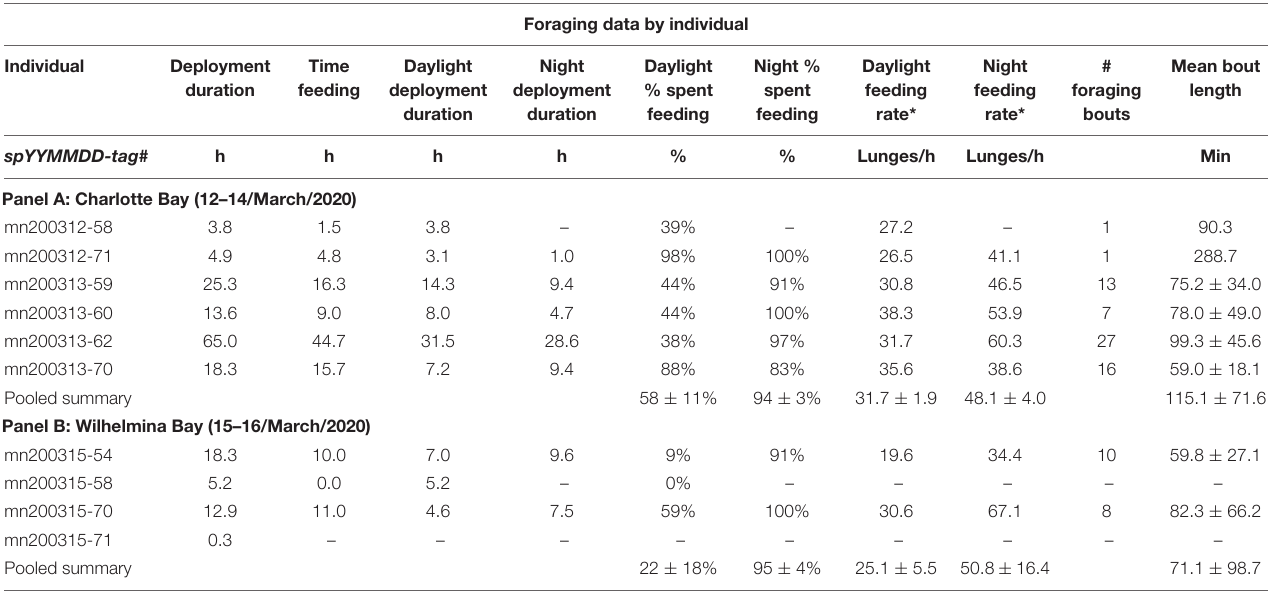
TABLE 2 | Deployment and foraging information for each tagged whale.